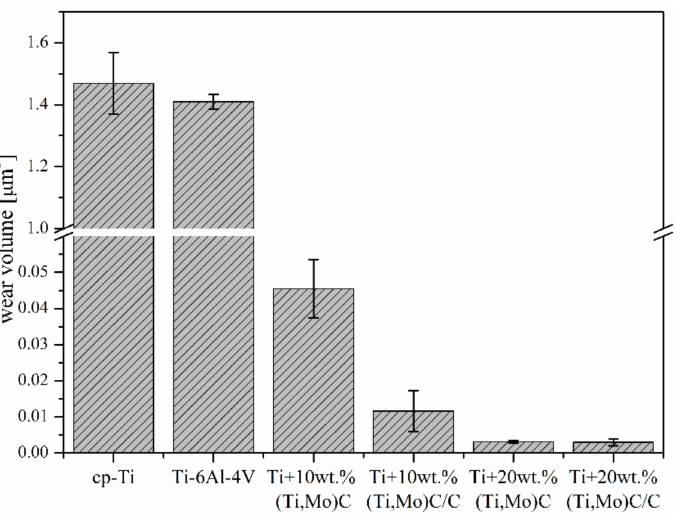
Figure 15. Wear volume of the composites with respect to reinforcing quantity of reference (Ti,Mo)C/C. The comparison of the results of corrosion tests of the Ti + (Ti,Mo)C and Ti + (Ti,Mo)C/C composites and reference specimens of cp-Ti and Ti-6Al-4V alloy are shown in Figures 16 and 17. The variation in the OCP of the composites exposed to a 3.5 wt % NaCl solution at